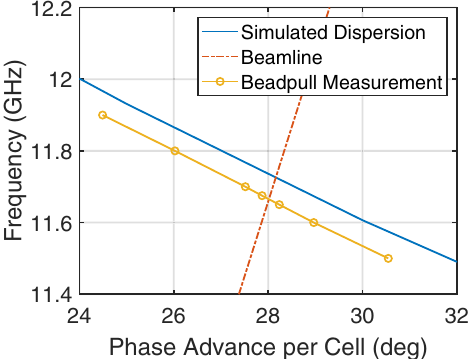
FIG. 12. Simulated dispersion compared to measured dispersion from beadpull cold test. The intersection point with the light line shows the experimental interaction frequency of 11.675 GHz.